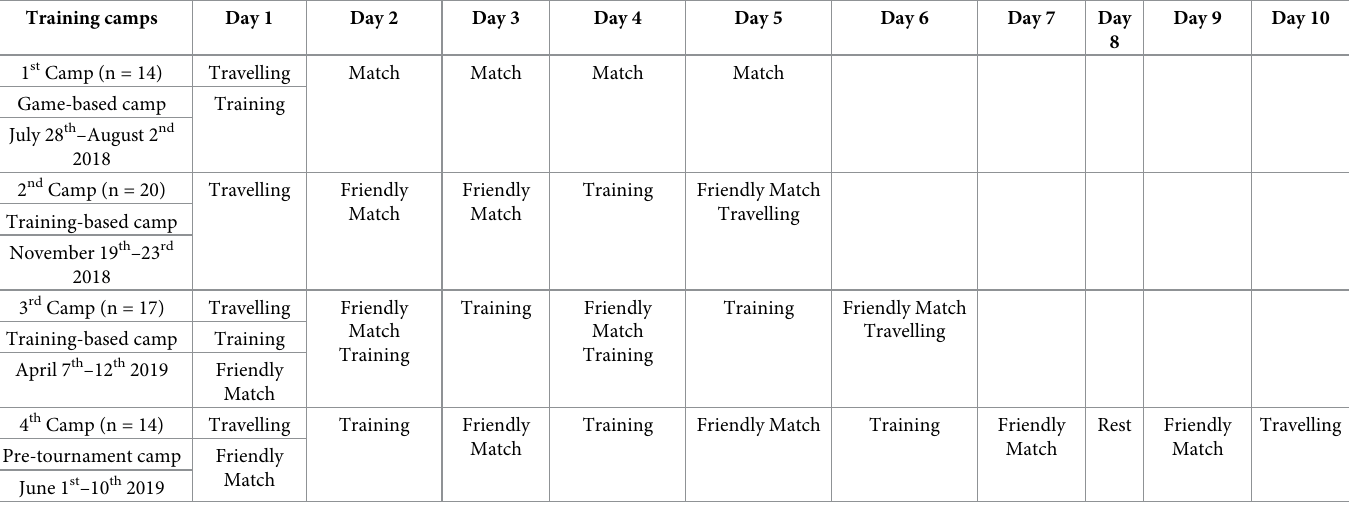
Table 1. The training schedule of the overseas training